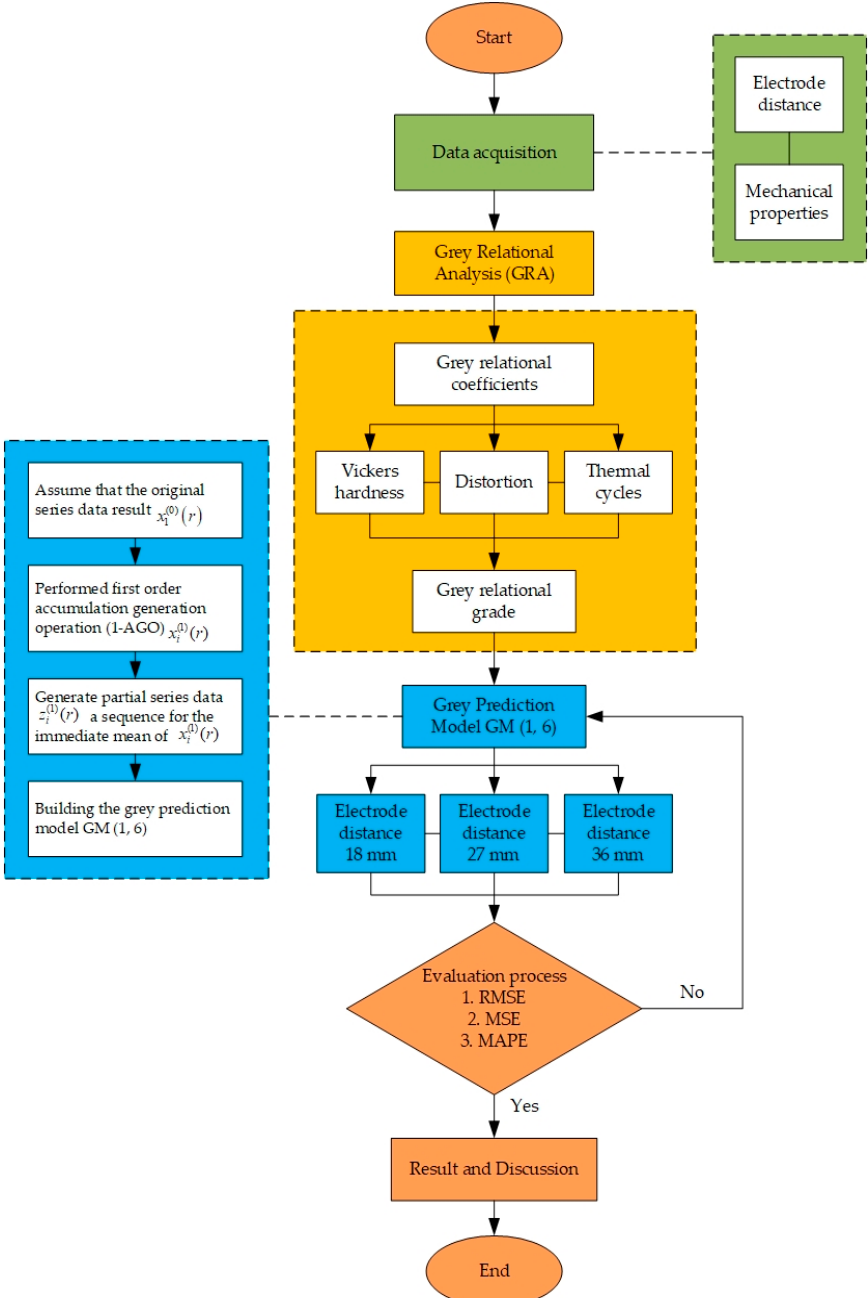
Figure 2. System